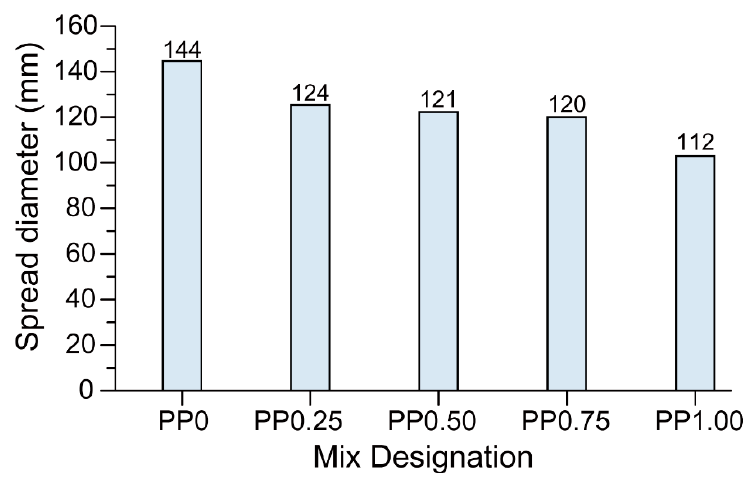
Figure 6. The shape-retention ability of 3D-printed geopolymer mortars in terms of the spread diameter measured under the action of the static load of 600 g.